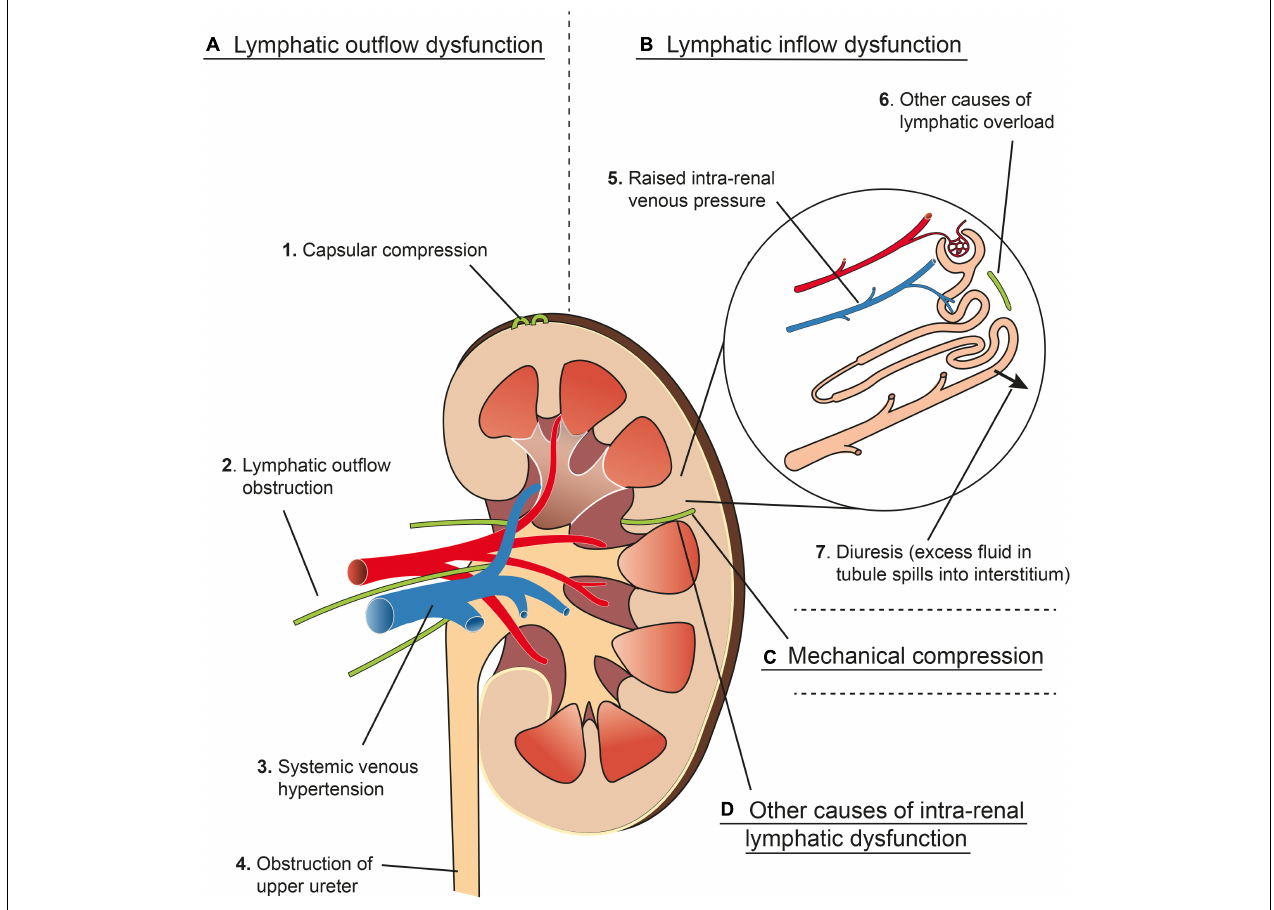
FIGURE 6 | Schema representing four main mechanisms (A–D) that contribute to renal interstitial edema. (A) Lymphatic outflow dysfunction. (1) Capsular compression: Communicating and perforating lymphatics drain the superficial cortex under normal circumstances but can drain more of the kidney if the hilar route is obstructed. These lymphatics can become blocked by mechanical compression from a tense renal capsule from renal interstitial oedema (see Renal Lymph Flow During Hydronephrosis and Figure 4 ). (2) Lymphatic outflow obstruction: Lymphatics draining the kidney at the hilum can be obstructed experimentally or clinically by metastatic disease, or can be resected during renal transplant, which causes an effective obstruction of flow (see Renal Interstitial Edema and Post-renal Transplant). (3) Central venous hypertension: raised pressure at the subclavian vein can prevent effective drainage from the thoracic duct, leading to increased renal lymphatic outflow pressure (see Congestive Heart Failure). Central venous hypertension also increases intra-renal venous pressure (see B5 ). (4) Obstruction of the upper ureter causes distension of the renal pelvis, which compresses hilar veins and lymphatics, and may cause pyelolymphatic backflow (see Renal Lymph Flow During Hydronephrosis and Pyelolymphatic Backflow). (B) Lymphatic inflow dysfunction (lymphatic overload). (5) Raised intra-renal venous pressure causes increased interstitial fluid and lymphatic flow (see Renal Lymph Flow During Increased Venous Pressure). (6) Other causes of lymphatic overload: Initial lymphatic capillaries can be overwhelmed when there is excessive interstitial fluid for other reasons e.g., hypoproteinaemia (see Renal Interstitial Edema). (7) Diuresis causes increased lymphatic flow because excess fluid in the renal tubules results in more fluid reabsorbed into the interstitial space (see Renal Lymph Flow During